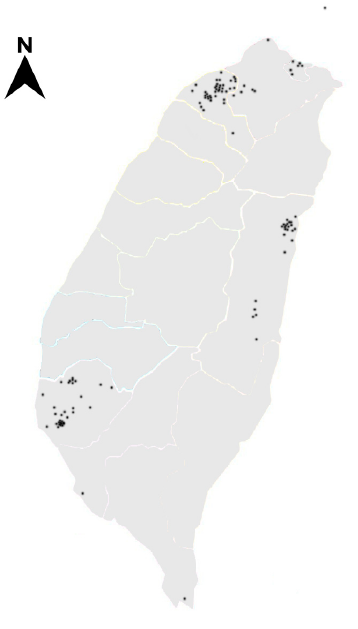
Figure 1. The locations of the 114 forensic cases in Taiwan (indicated by black spot).